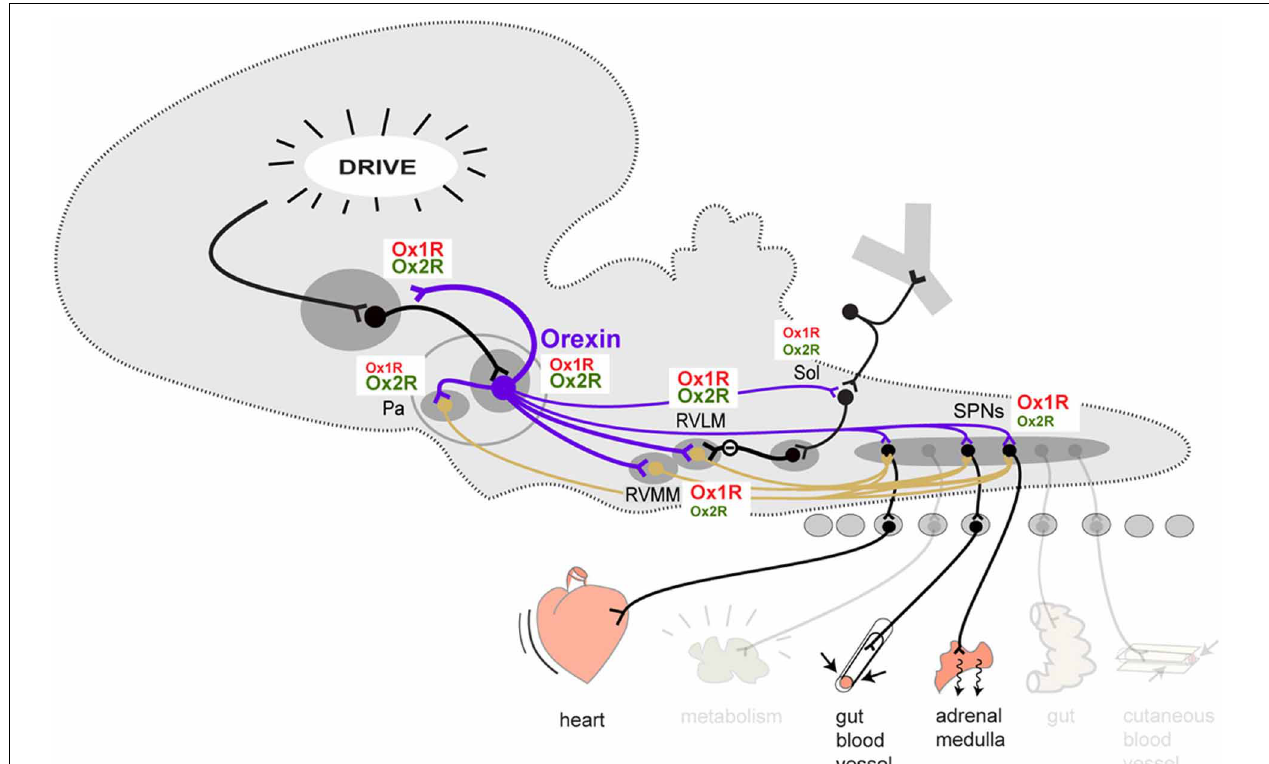
FIGURE 1 | Schematic overview of the orexinergic pathways involved in the descending controlof sympathetic output to cardiovascular effectors. The contribution of Ox1R and Ox2R at each level is represented by the relative size of the Ox1R and Ox2R labels. This is a tentative representation only,